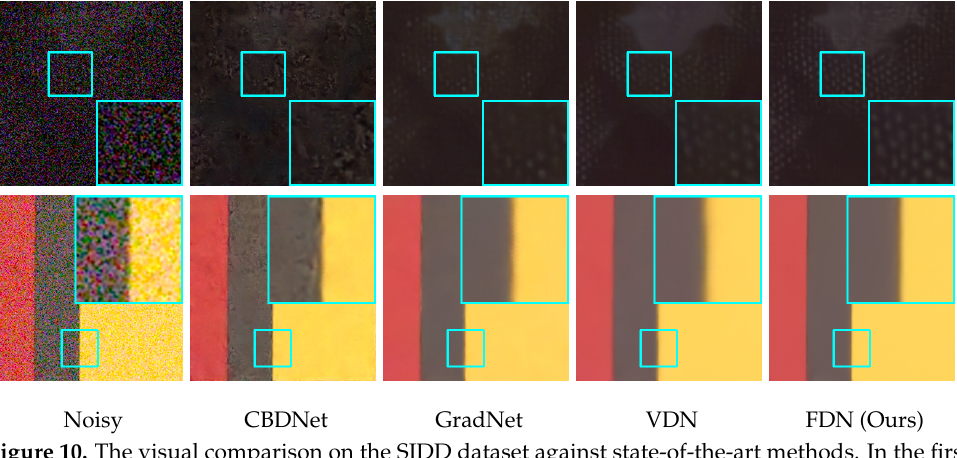
Figure 10. The visual comparison on the SIDD dataset against state-of-the-art methods. In the first row, FDN reconstructs the white dot patterns clearly in a dark environment without smoothing and artifacts. In the second row, FDN preserves more crisp edges.